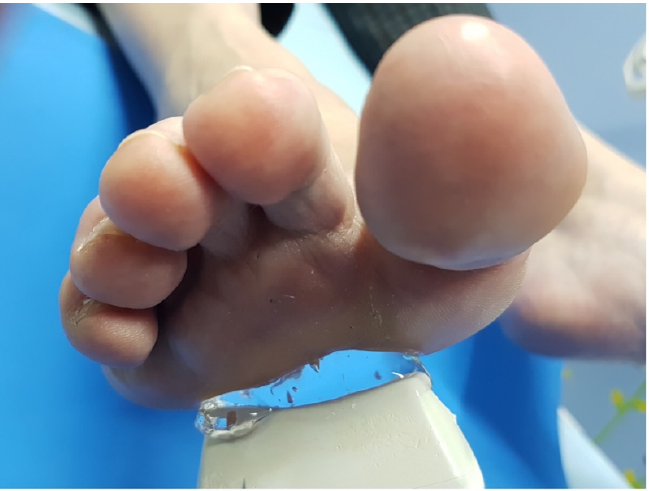
Figure 2. A generous amount of gel was applied between the skin and the probe, without adding pressure or touching the skin of the participant with the probe.